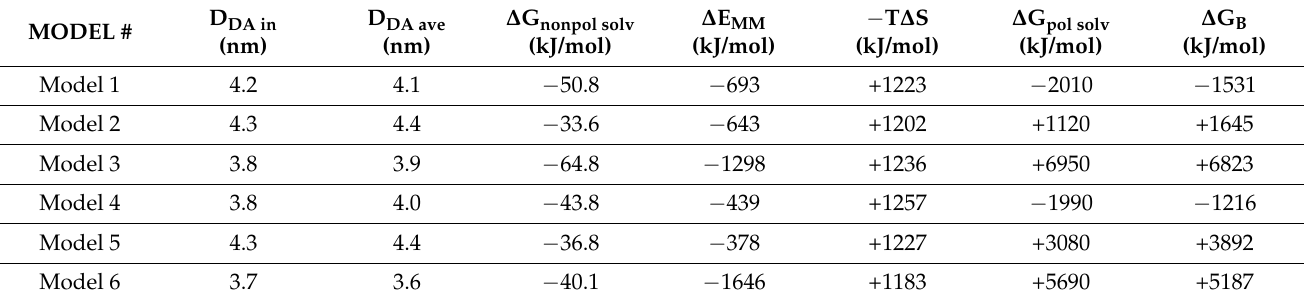
Table 1. Properties of the six models for the HSA/miR4749 complex. The distances between the 5 (cid:48) end of miR4749 and the aromatic ring center of the lateral chain of Trp214 at the beginning (D DA in ) and the average (D DA ave ) over the MD simulations are also reported. Binding free energy, ∆ G B , and its components for the six best HSA/miR4749 interaction models. ∆ G nonpol solv represents the nonpolar contribution to the solvation term, ∆ E MM , the internal energy, − T ∆ S MM , the entropic term and, finally, the ∆ G pol solv is the electrostatic contribution to the solvation